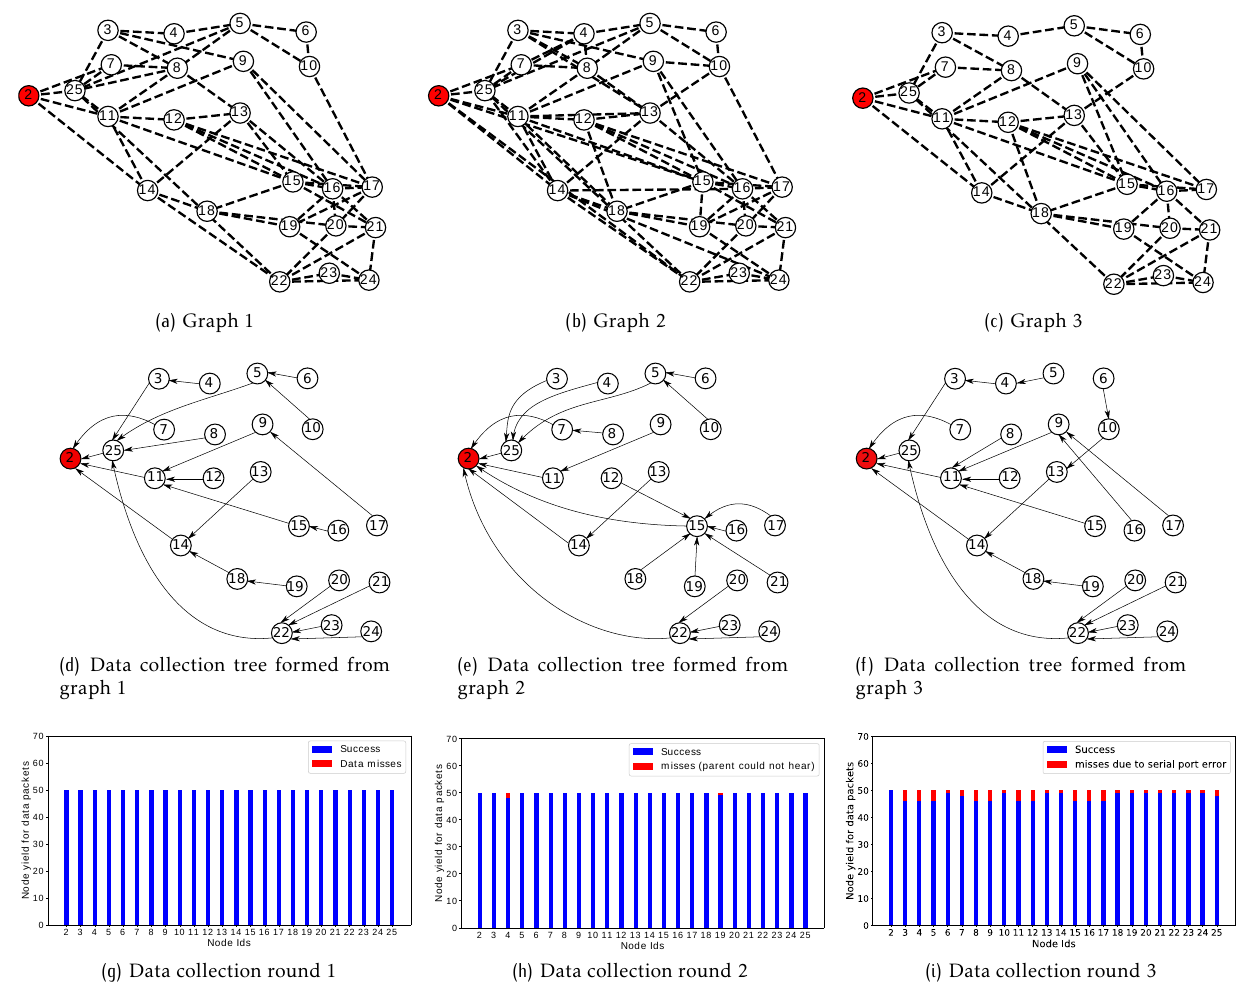
Figure 19. Consecutive graphs and respective data collection trees and the node yields for test case 1. Note that there was a temporary loose connection in the USB cable which is used to connect the sink node to the laptop for data logging and this is reflected as “serial port error” in Fig.